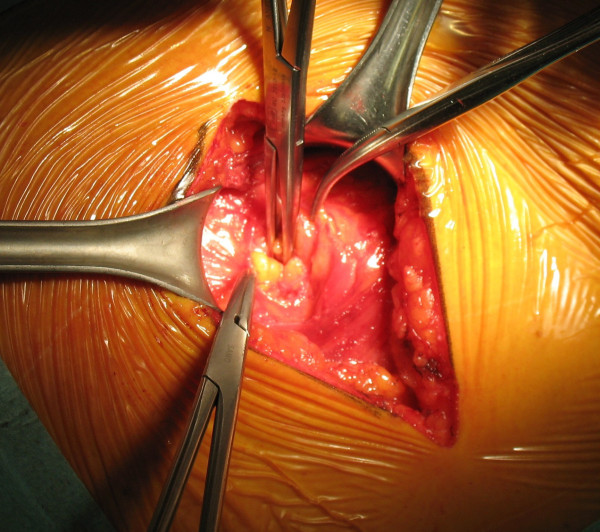
The parietal defect.